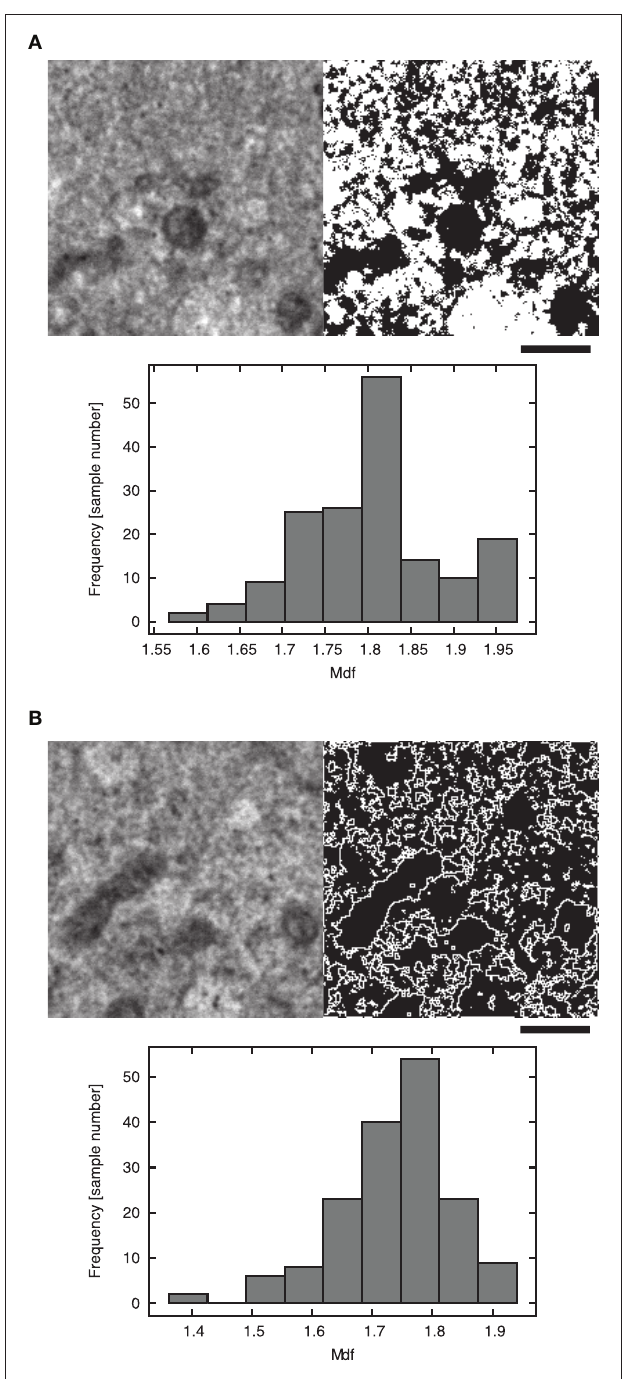
FiguRe 3 | Fractal dimension calculation from the material TeM images of rat fibroblast 3Y1 cells. (A) Image data from which we obtained M d . The f left and right panels display the original TEM and binarized images respectively. The histogram (bottom) displays the relationship between the value of the M d f (lateral) and the frequency of occurrence (vertical). (B) The data from which we computed S d . The left panel displays the original image. The image was once f processed into a binary image (A) ; afterward, binary images were used to estimate d of the mobile area in cytoplasmic material. The histogram shows f the relationship between the value of S d (lateral) and frequency of occurrence f (vertical). The scale bars represent